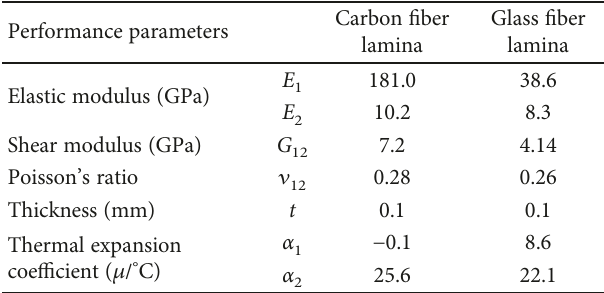
Table 1: Material properties of carbon fi ber lamina and glass fi ber